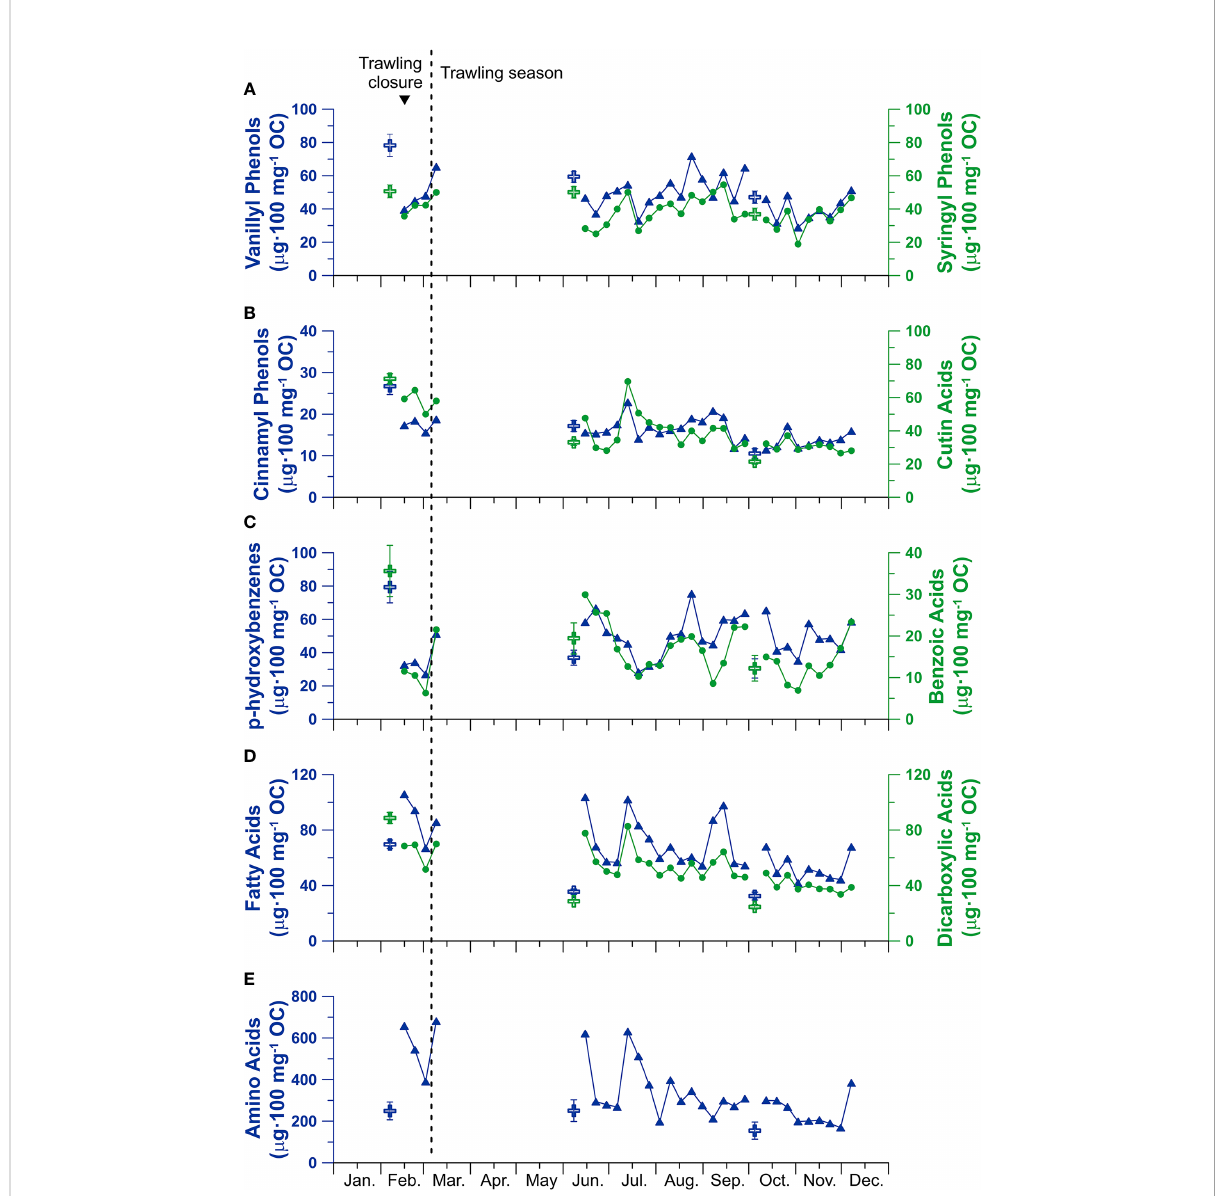
FIGURE 7 Temporal evolution of OC-normalized CuO compound classes in the sediment trap samples (Axis-1200). (A) terrestrial vanillyl (blue triangles) and syringyl (green circles) phenols, (B) terrestrial cinnamyl phenols (blue triangles) and cutin acids (green circles), (C) p-hydroxy benzenes (blue triangles) and benzoic acids (green circles), (D) fatty acids (blue triangles) and di-carboxylic acids (green circles), (E) amino acids (blue triangles). Values of sur fi cial sediment of the sediment core retrieved on the trawled fl ank in February, June, and October (Paradis et al., 2021b) are given with crosses. Note the different scales for each compound classes. The inverted triangle on top indicates the occurrence of a dense shelf water cascading